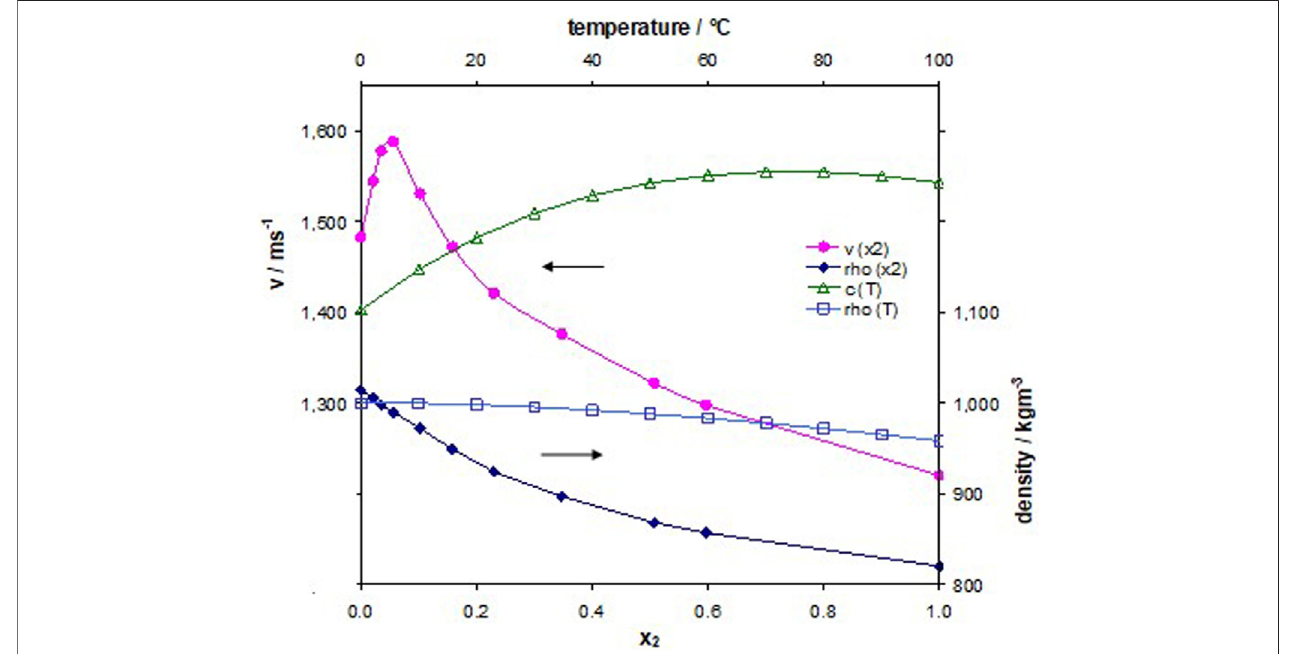
FIGURE 1 | The lower abscissa shows the relationship between speed of sound and density of a water-1-propanol-mixture vs. the molar ratio of 1-propanol. The upper abscissa shows the relation of speed of sound and density of water vs